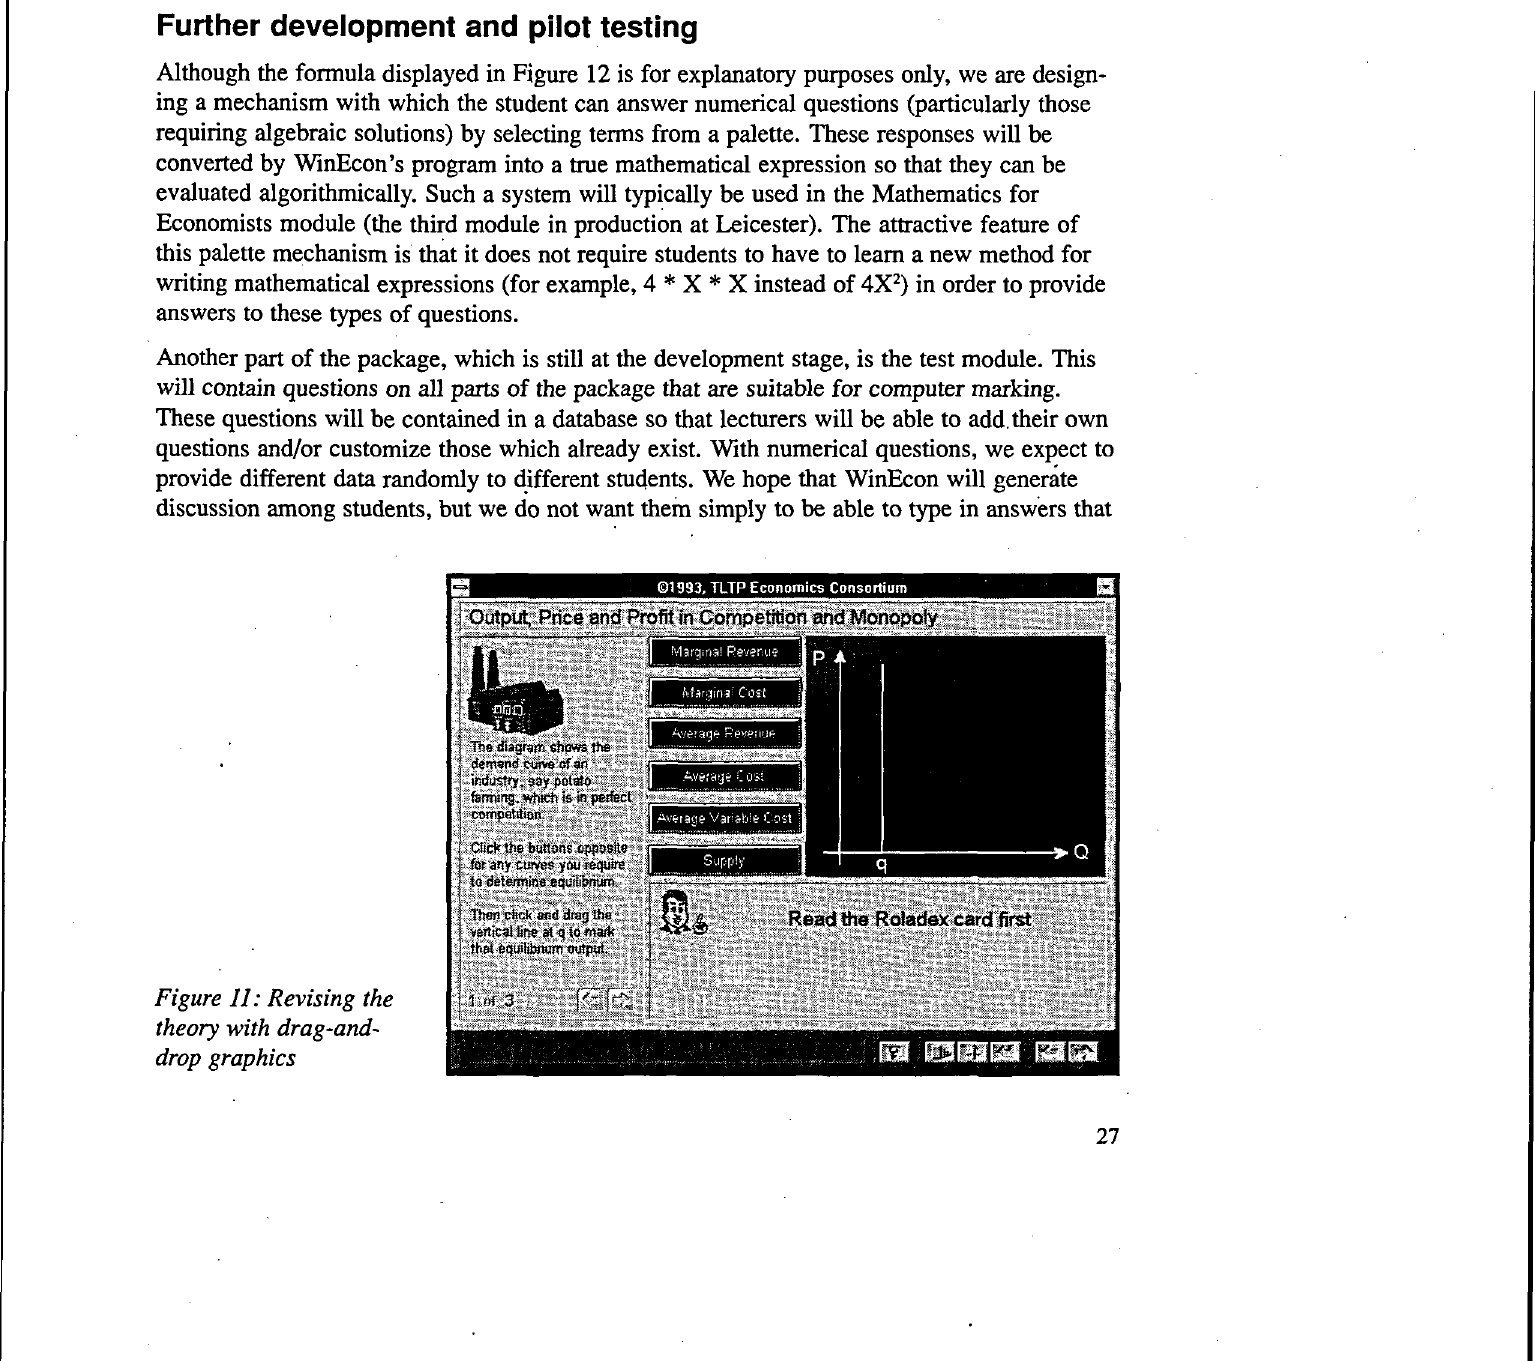
Figure 11: Revising the theory with drag-and- drop